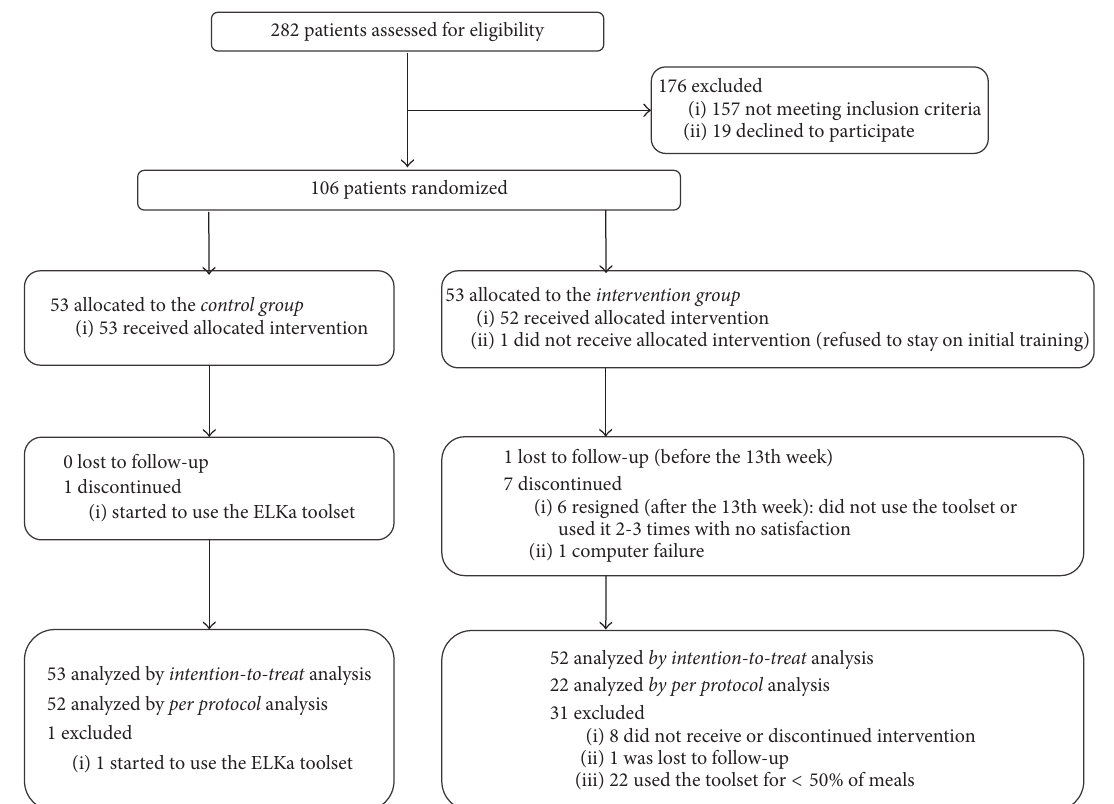
Figure 2: Participants’ passage through the study.